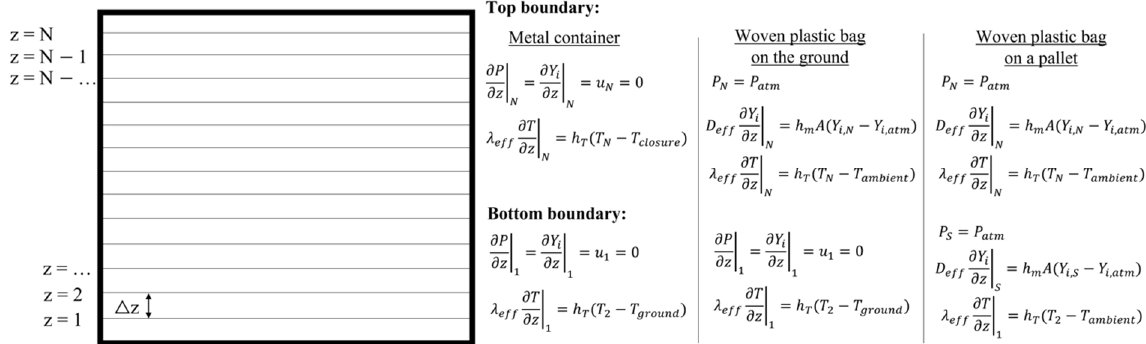
Figure 2. Discretization and the boundary conditions.